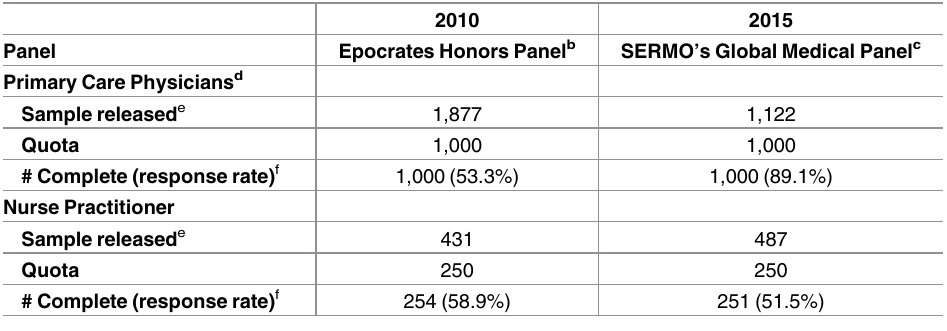
Table 1. Differencesbetween 2010 and 2015 DocStyles survey a